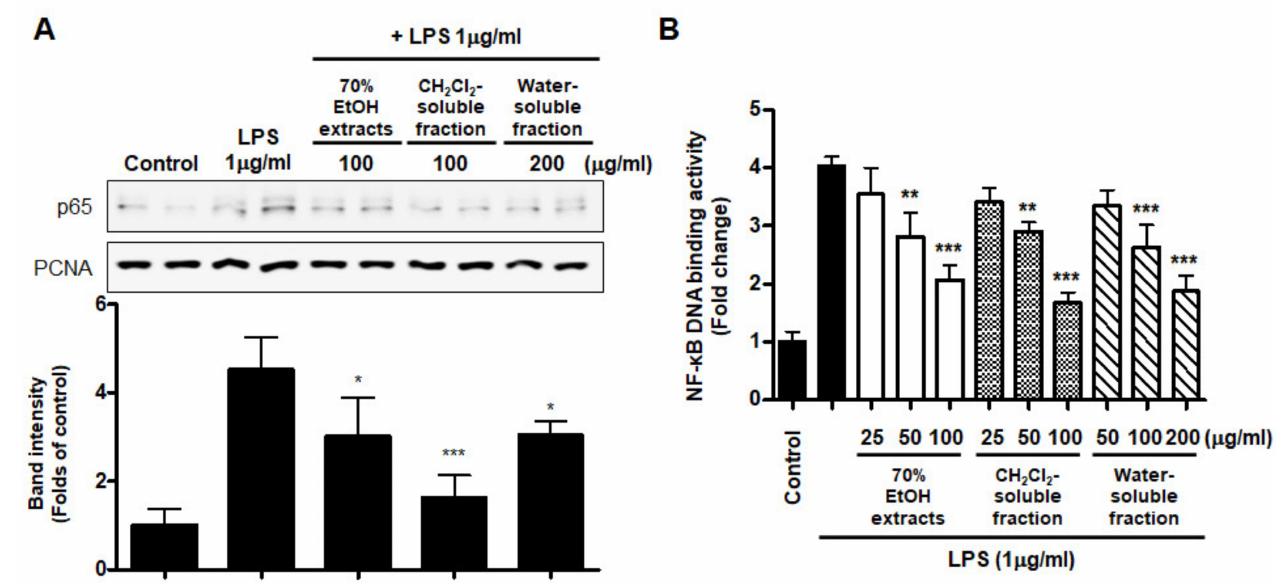
Figure 9. Effects of 70% EtOH extract and its CH 2 Cl 2 - and water-soluble fractions on NF- κ B p65 activation ( A ) and NF- κ B DNA-binding activity ( B ) in BV2 cells. Cells were pretreated with the indicated concentrations of 70% EtOH extract and its CH 2 Cl 2 - and water-soluble fractions for 3 h and stimulated with LPS (1 µ g/mL) for 1 h. The method used to perform the Western blot analysis for nuclear NF- κ B translocation is described in detail in the Materials and Methods section. Immunoblots were quantified using ImageJ software. Band intensity was normalized to PCNA. A commercially available NF- κ B ELISA kit was used to test the nuclear extracts and determine the NF- κ B binding levels. Data are the mean values of 3 independent experiments. * p < 0.05, ** p < 0.01, *** p < 0.001 compared to LPS-treated group. Control means an untreated control group.